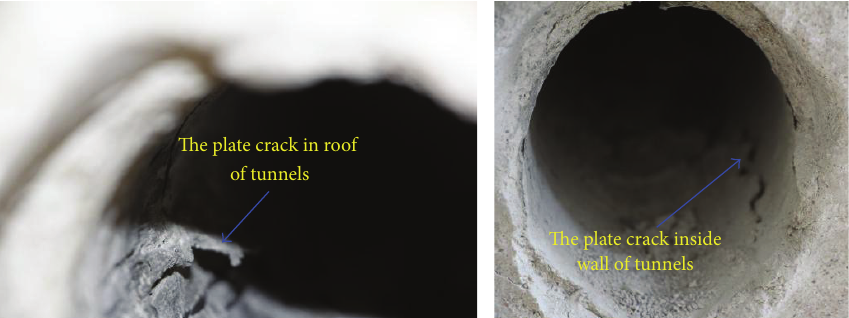
Figure 14: The plate cracking phenomenon.